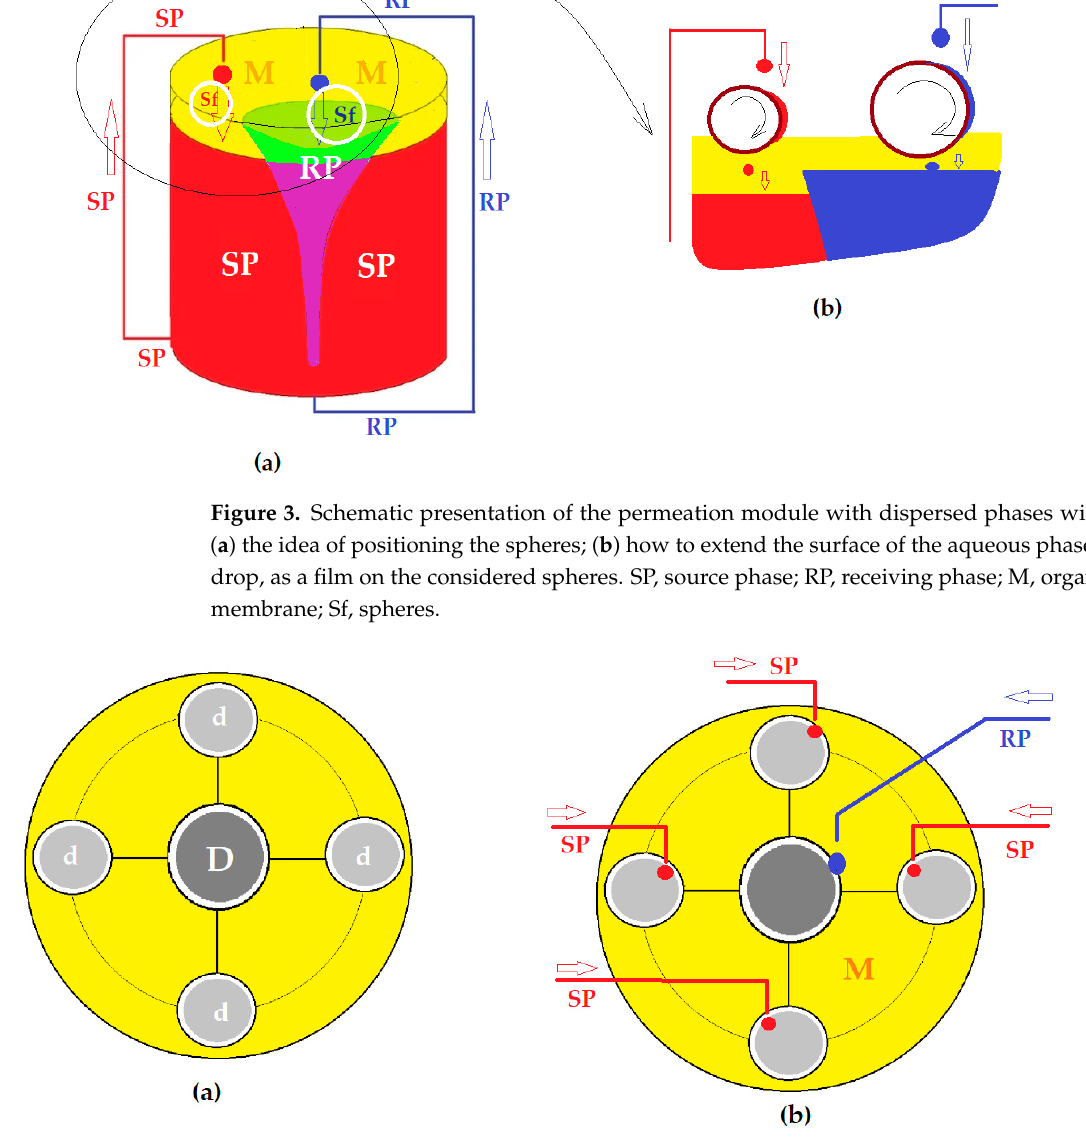
Figure 4. Schematic presentation of the positioning of the distribution spheres ( a ); and of the aque- ous phases ( b ). d, spheres for the distribution of the source phase (SP); D, sphere for the distribution of the receiving phase (RP) in the liquid membrane (M).